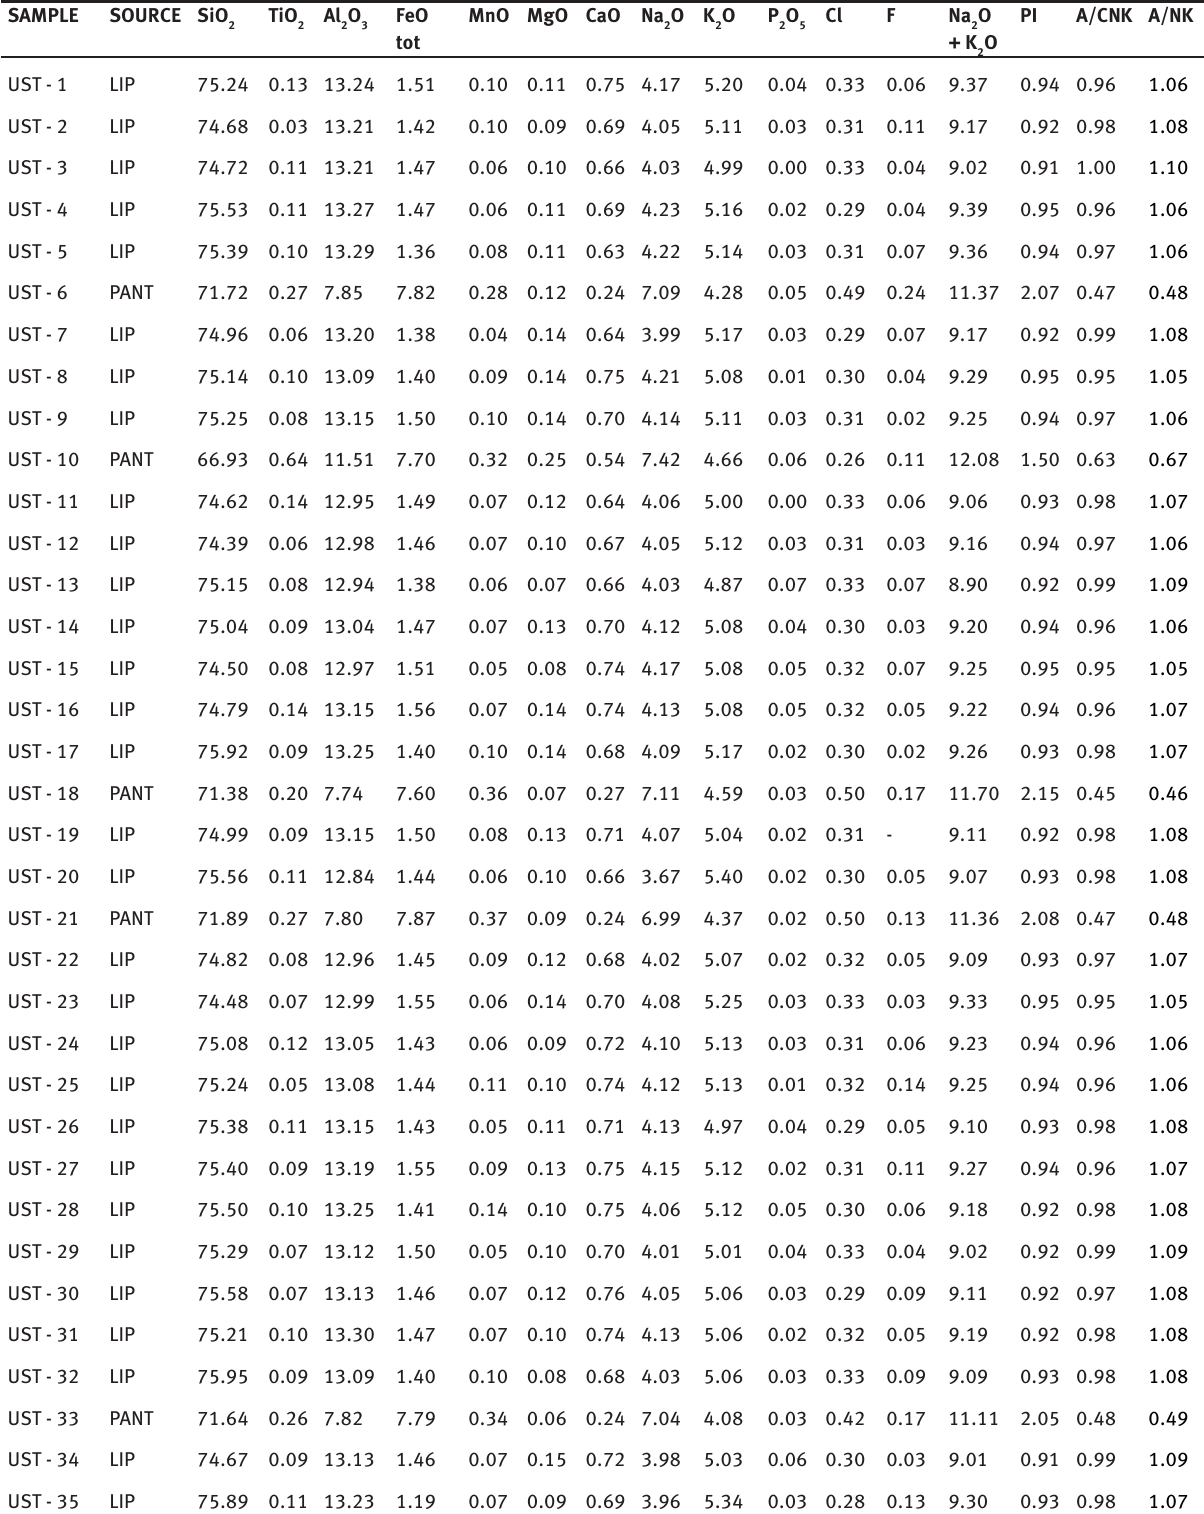
Table 4: Major and minor element wt % content of archaeological samples analyzed in this study. PI = peralkalinity index; A/CNK = alumina saturation index; A/NK = Shand (1927) index. UST-69 sample was discarded because it resulted to be non-obsidian. LIP = Lipari; PANT =